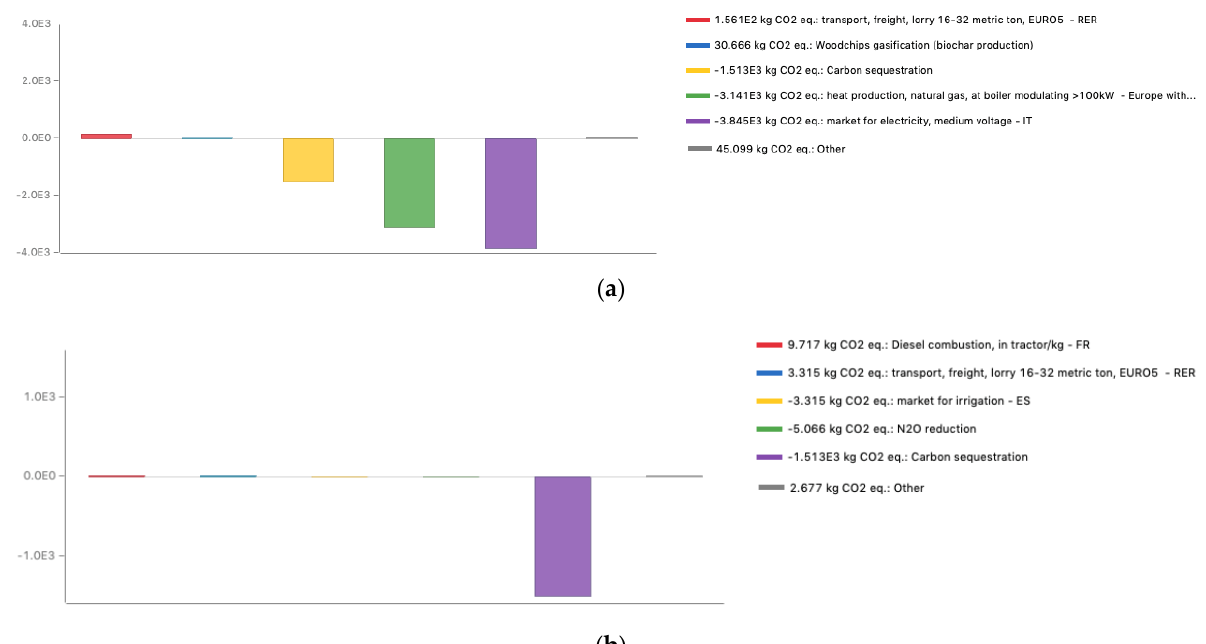
Figure 4. Climate change–GWP 100: top 5 contributions impacting category results: ( a ) Cradle-to-grave analysis; ( b ) Downstream process.